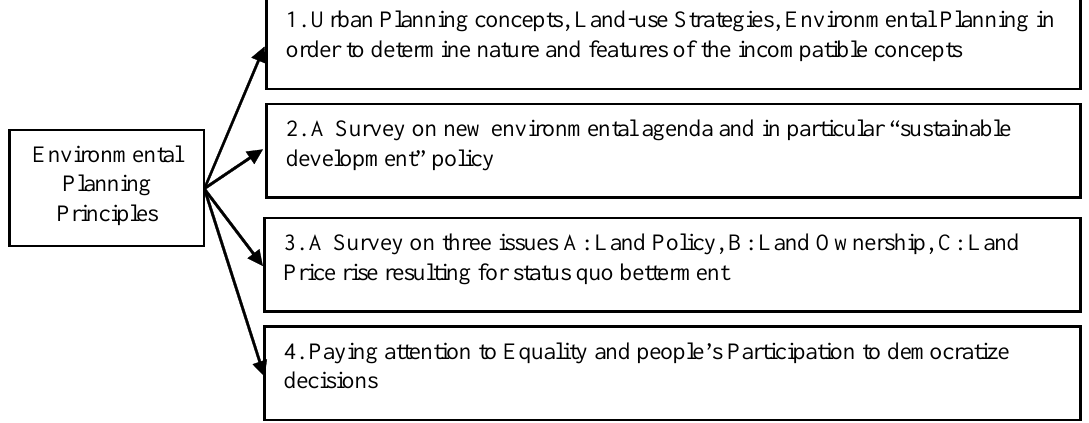
Fig. 1: Environmental planning principles (Abdi Daneshpour,